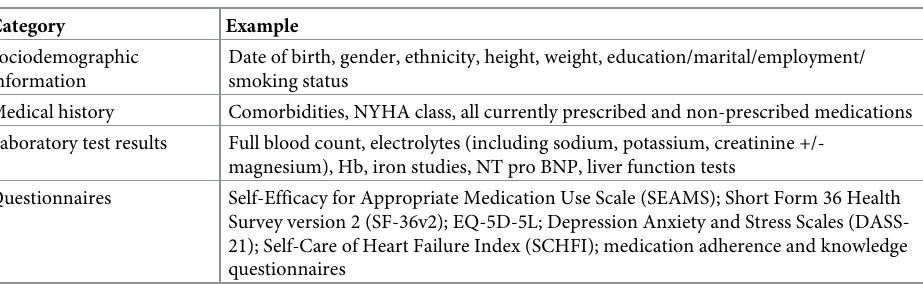
Table 2. Baseline